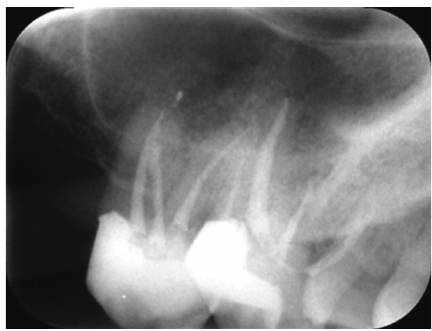
Figure 3: A 1-year follow-up periapical